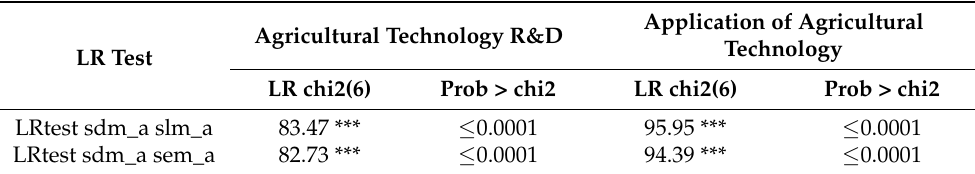
Table 9. LR test of the regression results of agricultural technological innovation and green agricul- tural development under the economic matrix.